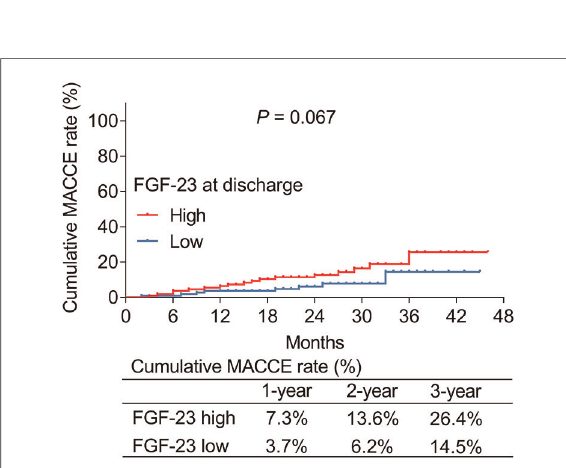
FIGURE 4 FGF-23 (at discharge) level exhibited a trend to be positively correlated with the cumulative major adverse cardiac and cerebrovascular event rate in unprotected left main coronary artery disease patients receiving coronary artery bypass